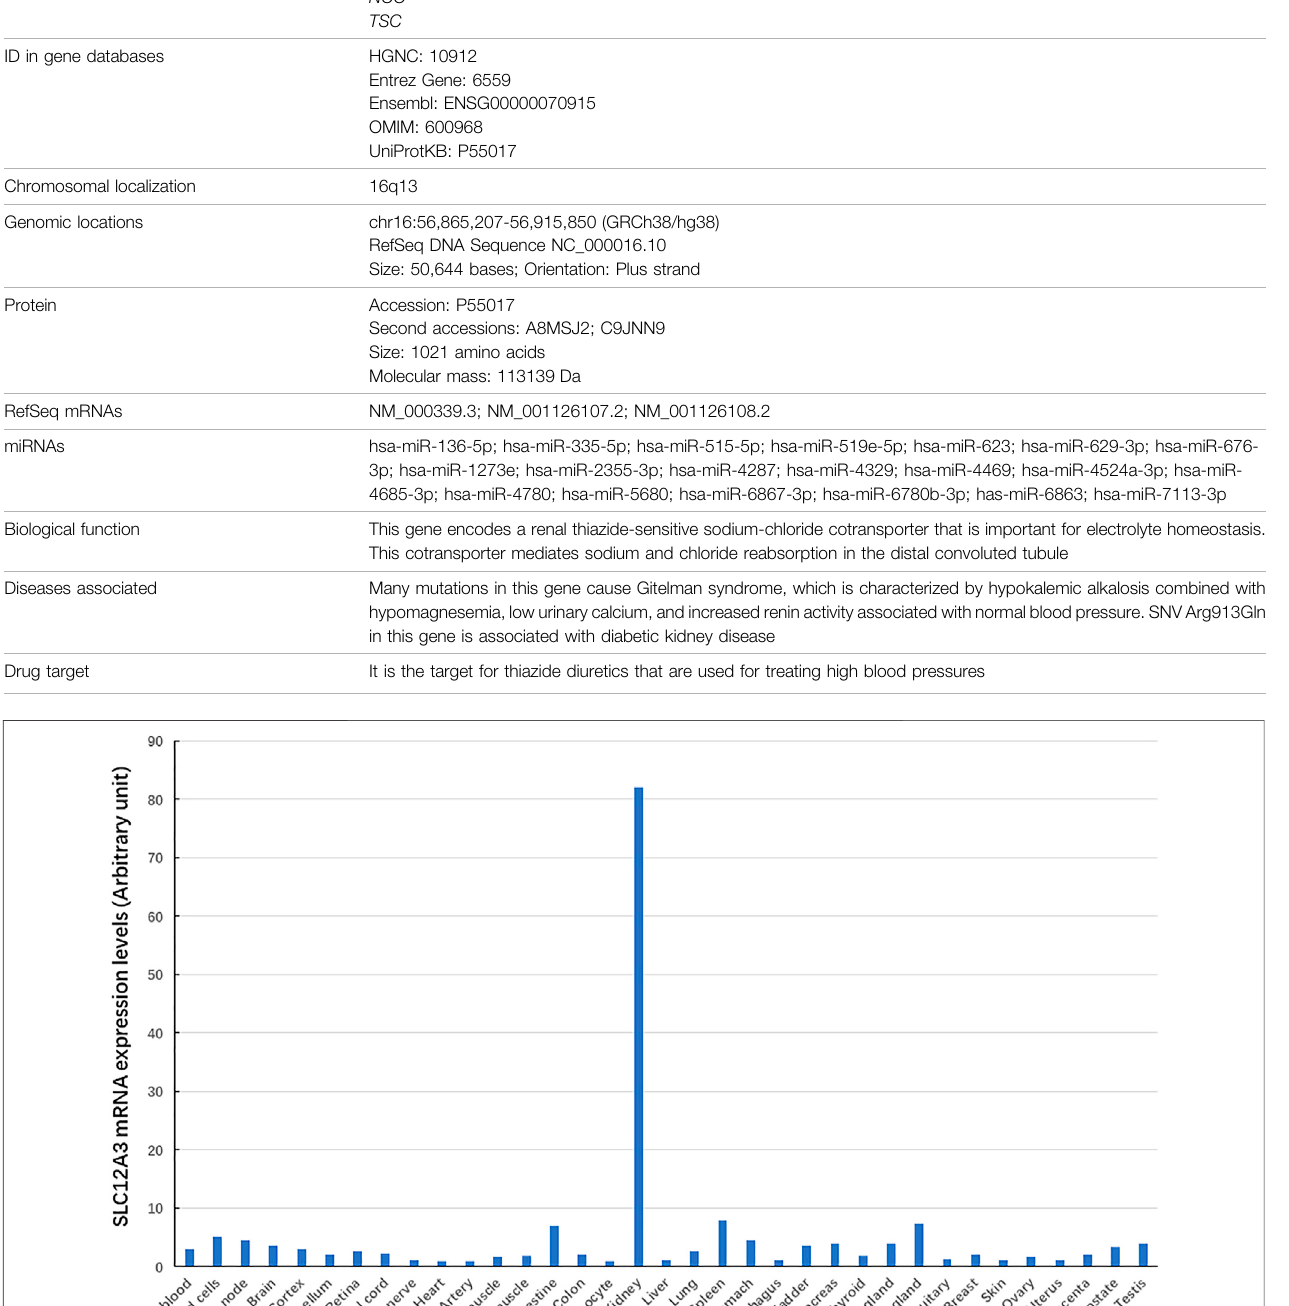
Frontiers in Genetics |